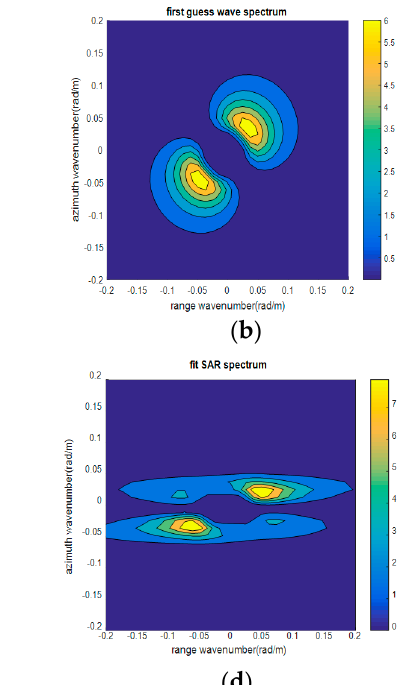
( d ) Figure 12. SAR-2: MPI algorithm inversion results as follows: ( a ) Observed SAR spectrum (after horizontal flip), ( b ) first guess PM wave spectrum, ( c ) fit PM wave spectrum, and ( d ) fit SAR spectrum. For SAR-3, the wave propagation direction is also 45°. The orbital angle of SAR-3 and SAR-1 is − 50°, and it can be calculated that the angle between the wave propagation direction and the range